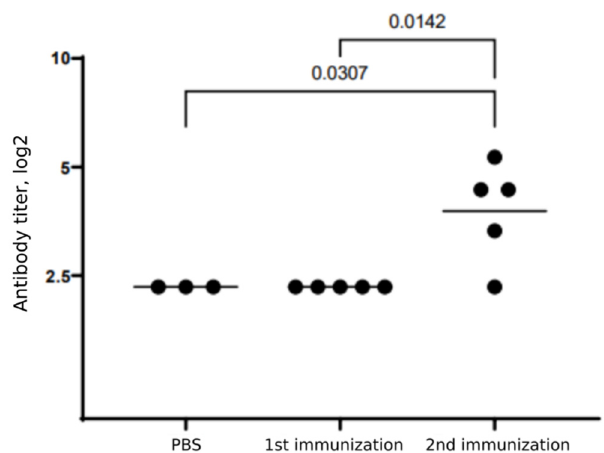
Figure 5. Neutralizing antibody responses in mice following single or double immunization with Betuvax-CoV-2. BALB/c mice were injected ip with 5 µg Betuvax-CoV-2. Points indicate the individual values, horizontal line—GMT for each group. Statistical analysis was performed using ANOVA with subsequent pairwise comparison using Tukey test.